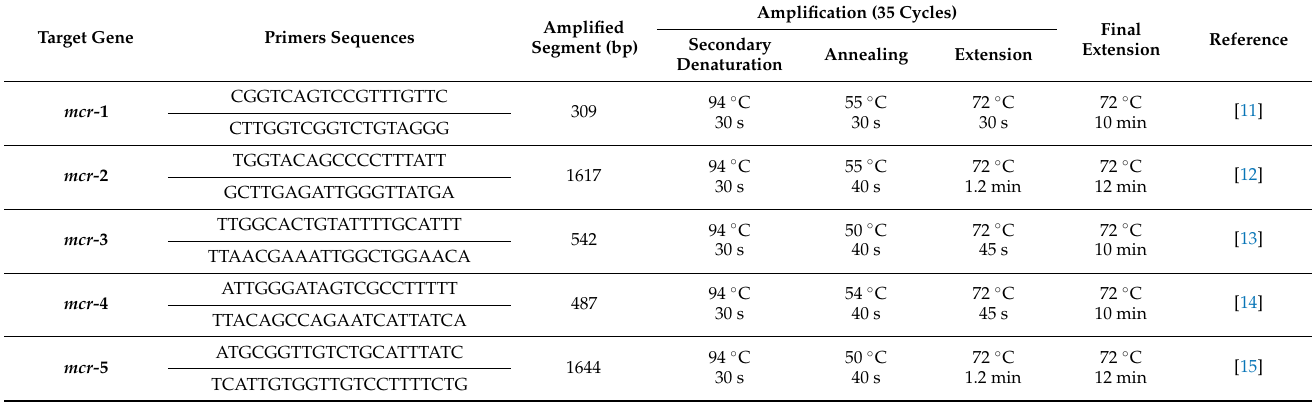
Table 1. Primer sequences, objective genes, amplicon sizes and cycling conditions.